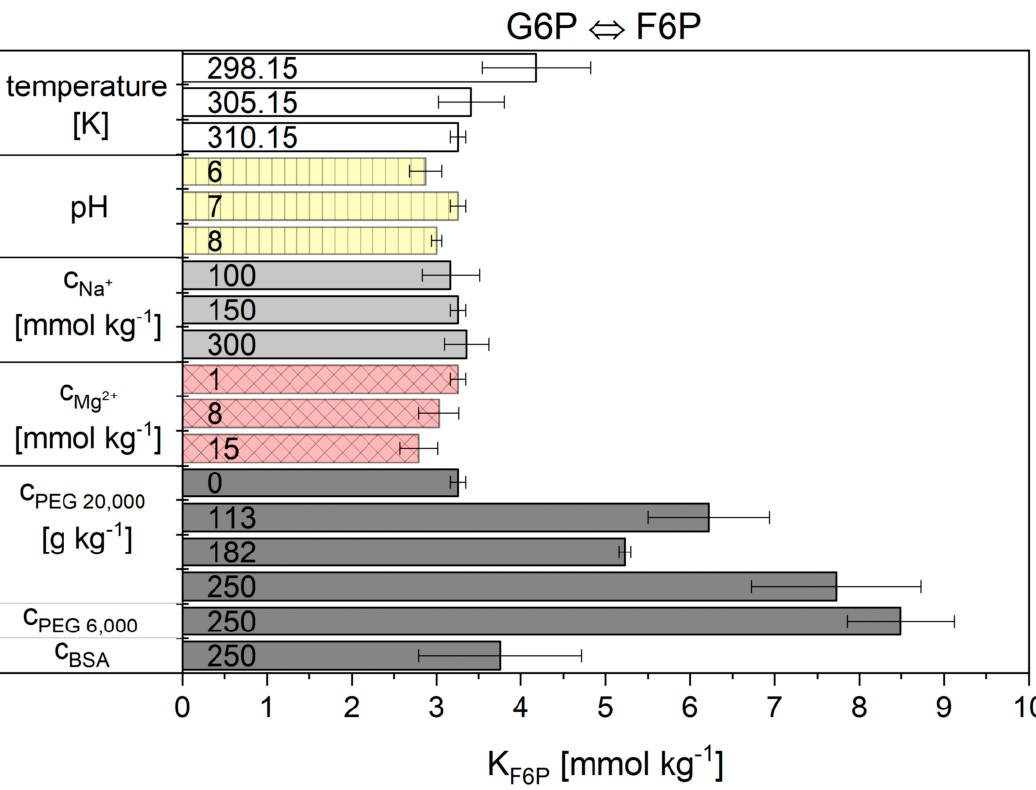
Figure 3. K F6P values obtained for reaction 2 from the Noor model. The error bar results from the standard deviation of the triple determination of each measurement condition.